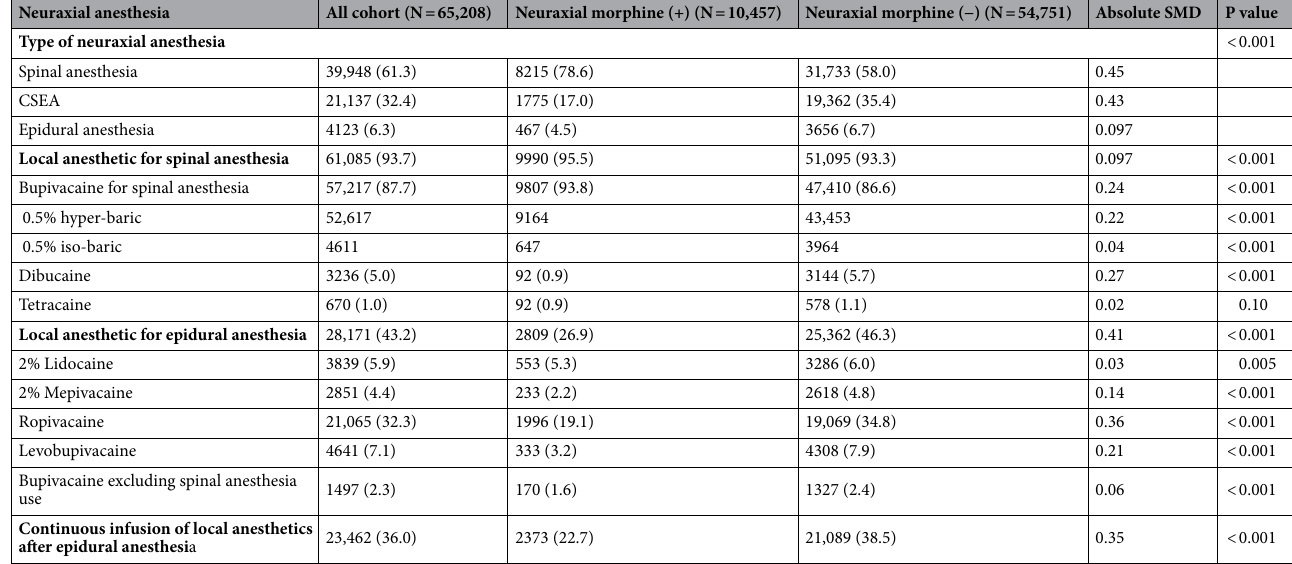
Table 2. Characteristics of neuraxial anesthesia used for cesarean deliveries. Values are given as frequencies (%) unless stated otherwise. Absolute SMD > 0.1 indicates significant imbalance between anesthesia with